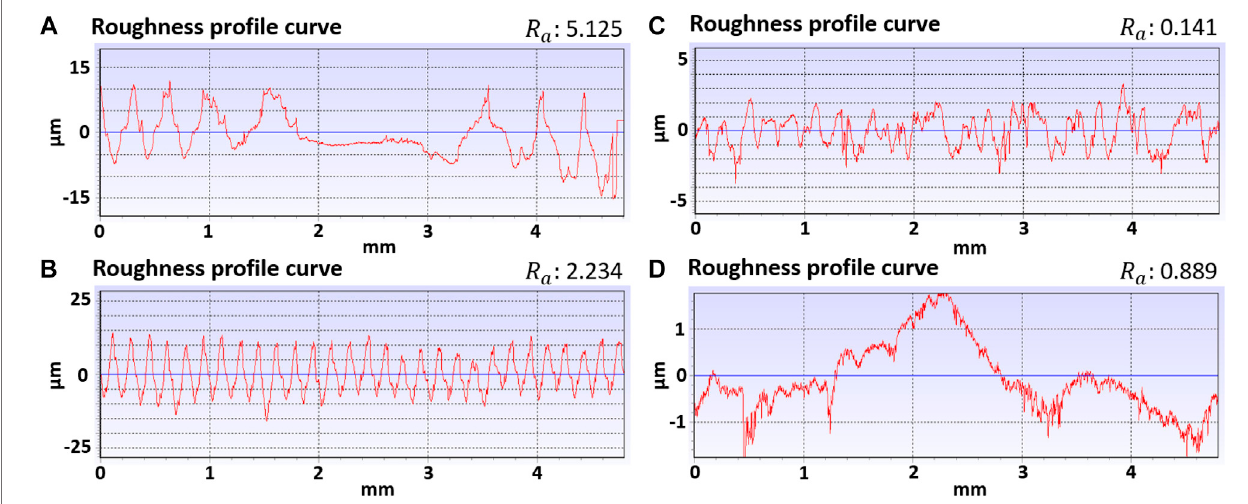
FIGURE 2 | Original surface roughness value of the tailor welded blank: (A) roughness of the weld along the welding direction, (B) roughness of the weld perpendiculartotheweldingdirection, (C) roughnessofthebasedmaterialalongtheweldingdirection, (D) roughnessofthebasedmaterialperpendiculartothewelding direction.